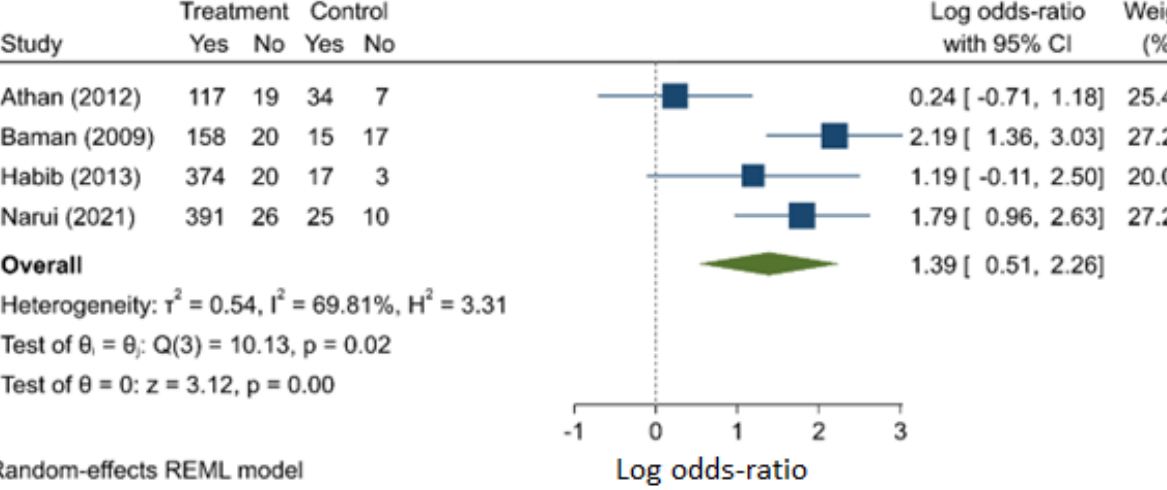
Figure 3. Presence of embolism/embolic phenomena as a risk factor for mortality.